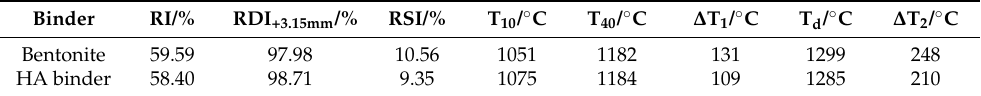
Table 5. Metallurgical properties of fired VTM pellets obtained using different binders. Binder RI/% RDI +3.15mm /% RSI/% T 10 / ◦ C T 40 / ◦ C ∆ T 1 / ◦ C T d / ◦ C ∆ T 2 / ◦ C Bentonite